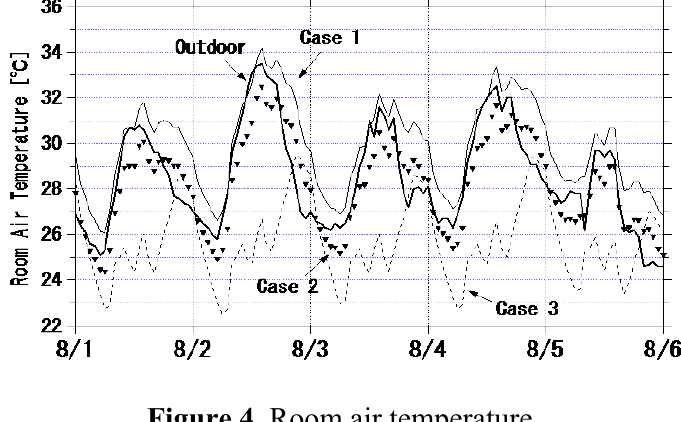
Figure 4. Room air temperature.